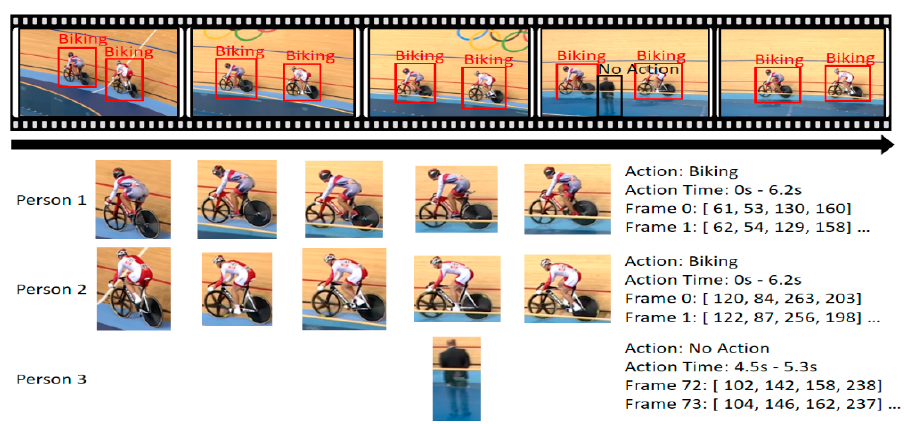
Figure 1. Examples of spatio-temporal action detection.